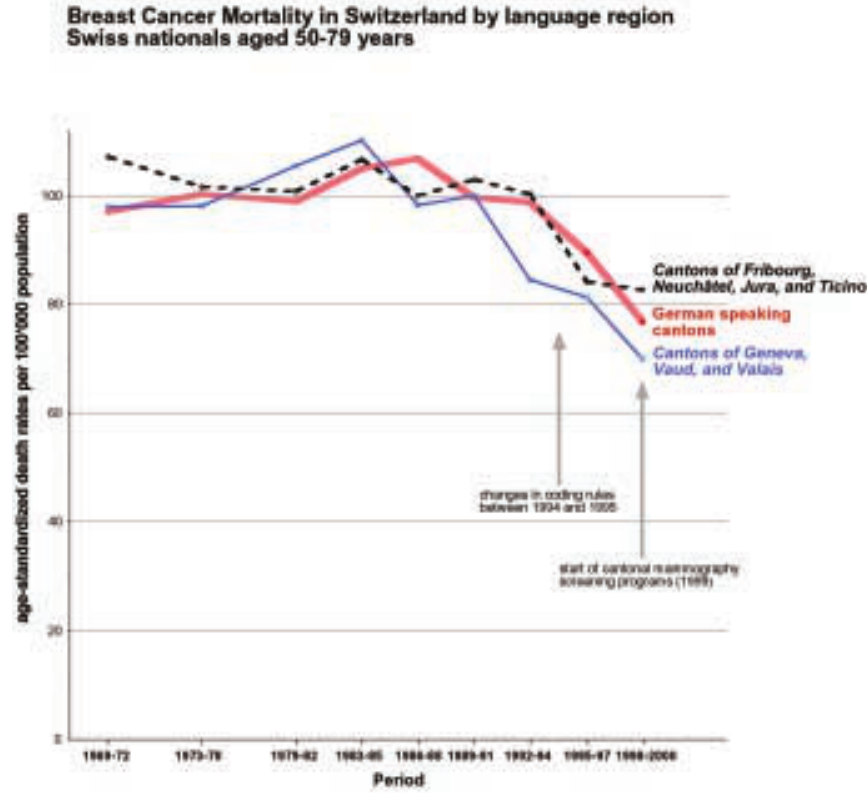
Breast cancer mortality rates (per 100 000 fe- male population) in Switzerland by language region and calendar time periods for Swiss na- tionals aged 50–79. Rates are age-standardised to the Swiss female population at the end of 1990. Calendar years were grouped in the fol- lowing periods: 1969–72, 1973–78, 1979–82, 1983–85, 1986–88, 1989–91, 1992–94, 1995–97,